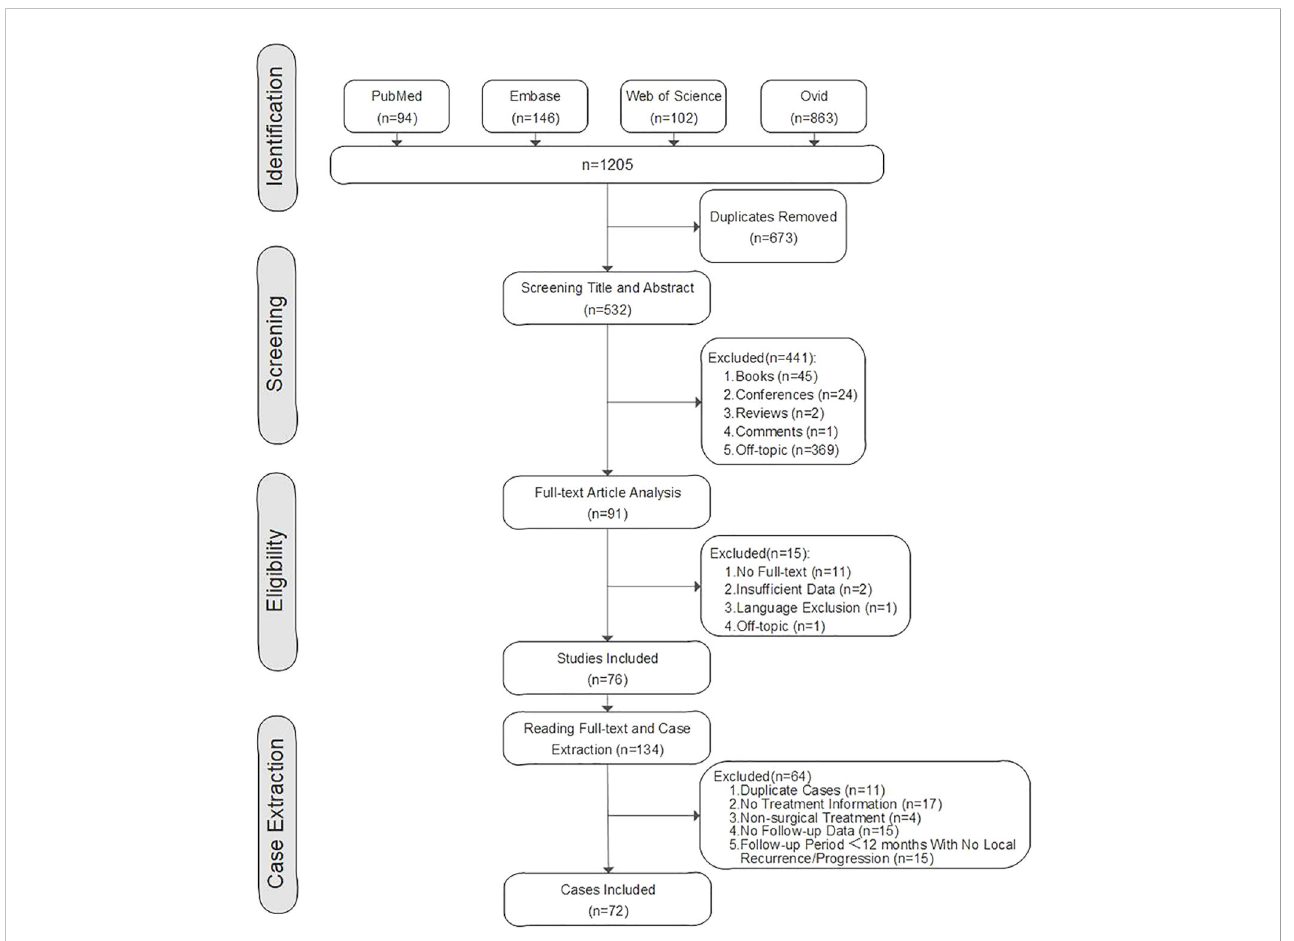
FIGURE 1 Flow Diagram of Literature